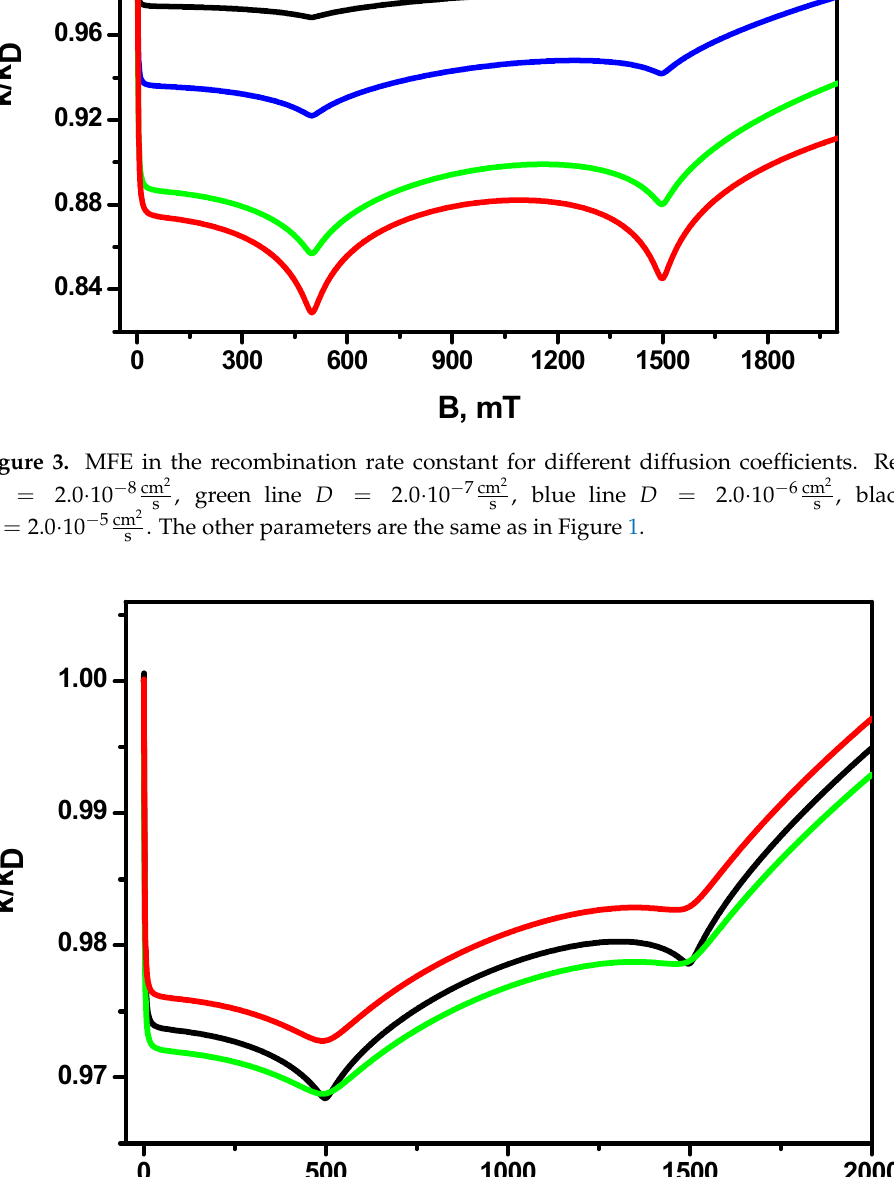
Figure 4. Magnetic field effect k(B)/k(B = 0) for different relaxation times. Black line: T 1 A = 1000 ns, T 2 A = 1000 ns; green line: T 1 A = 1000 ns, T 2 A = 250 ns; red line: T 1 A = 250 ns, T 2 A = 250 ns. The other parameters are the same as in Figure 1.